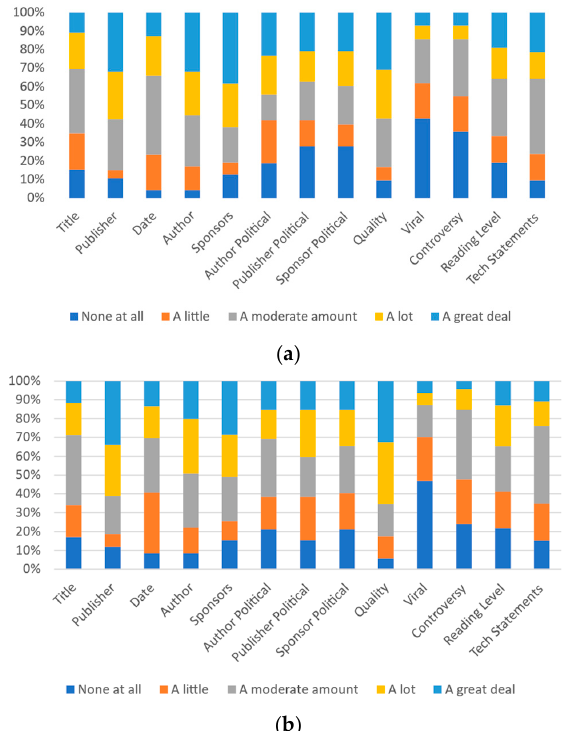
Figure 7. Participants’ responses on the ideal magnitude of each category’s effect on perception of trustworthiness or credibility: ( a ) University A and ( b ) University B.